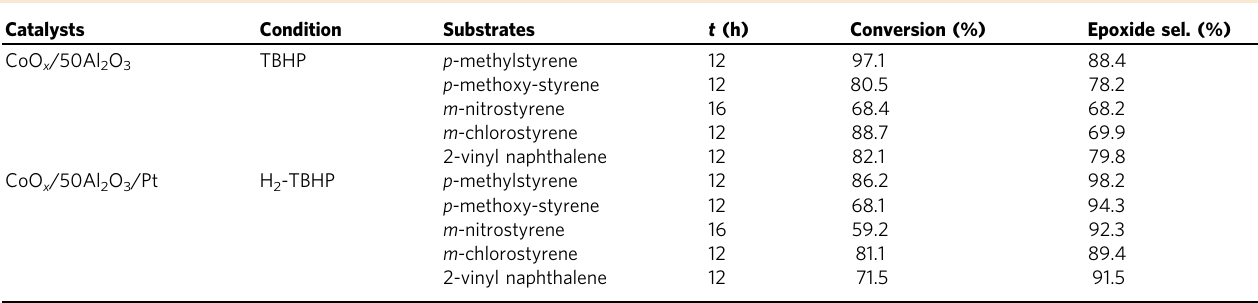
Table 3 Catalytic epoxidation of styrene derivatives in different conditions a .